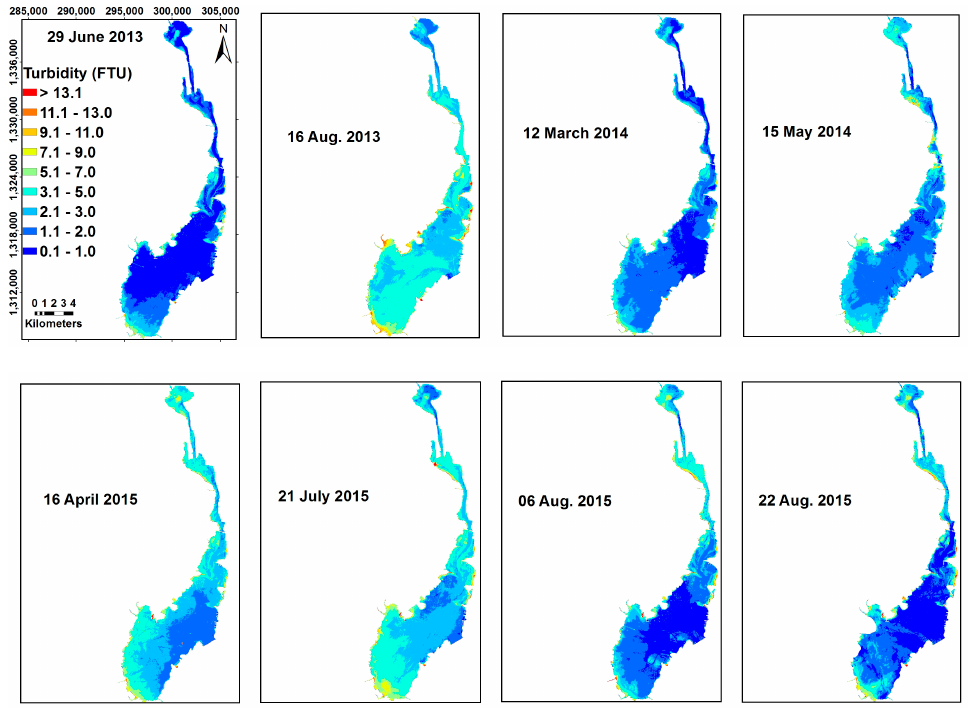
Figure 8. Turbidity distributions shortly after rainfall in dry season (cloud cover areas masked).